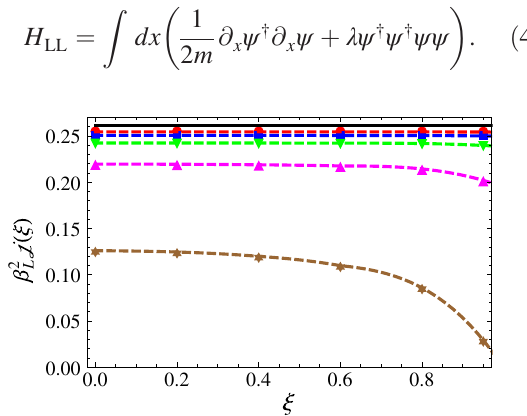
j ð ξ > 0 Þ for β 30 β and R ¼ L L j ð ξ Þ ¼ π 1 − 1 which, as 12 ð 900 Þ L